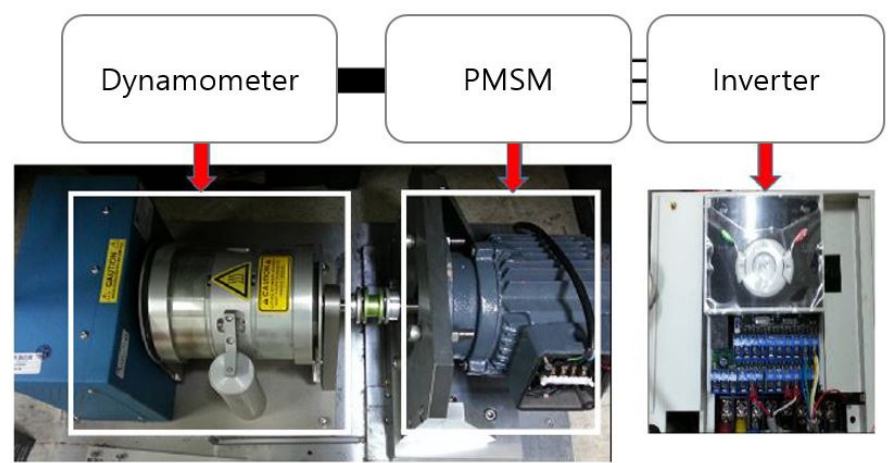
Figure 4. Experimental